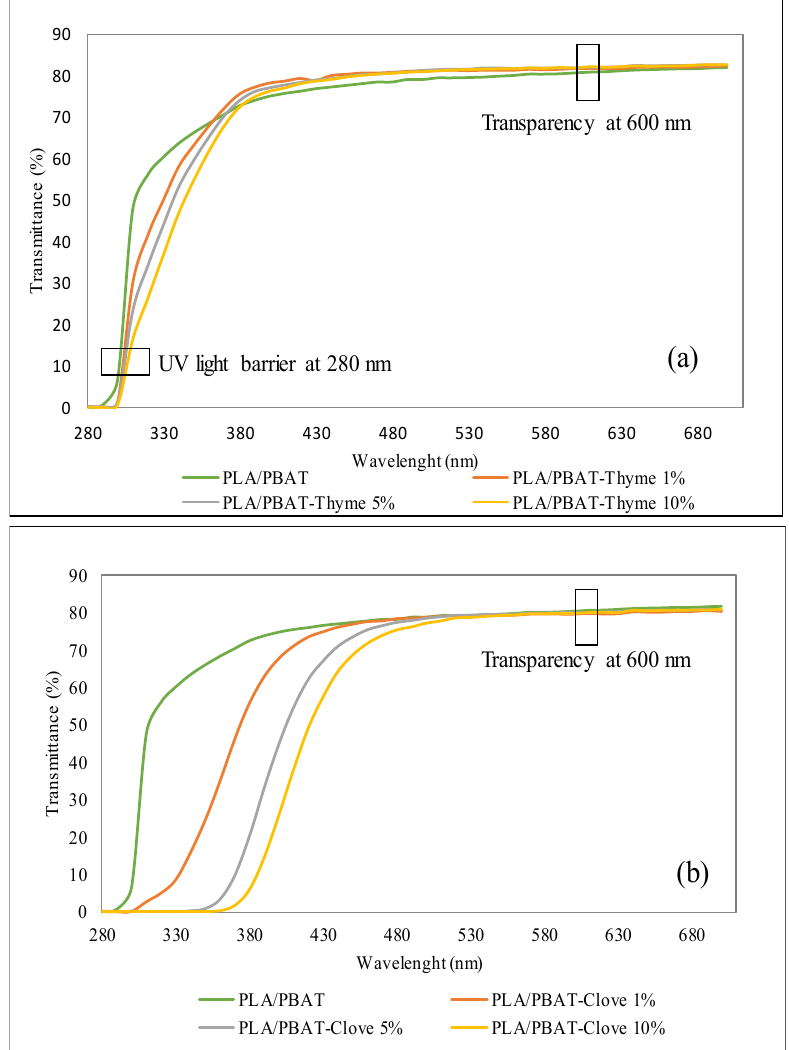
Figure 1. Light transmittance spectra of PLA/PBAT incorporated with ( a ) thyme oil and ( b ) clove oil composite film.